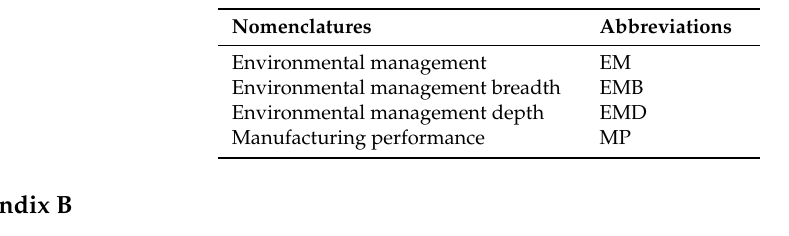
Table A2. Survey